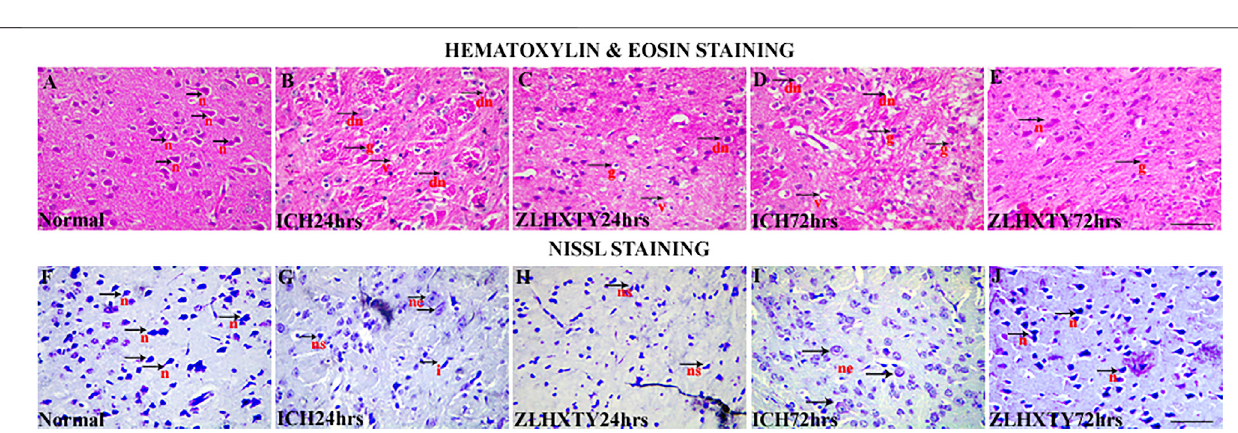
Frontiers in Pharmacology |